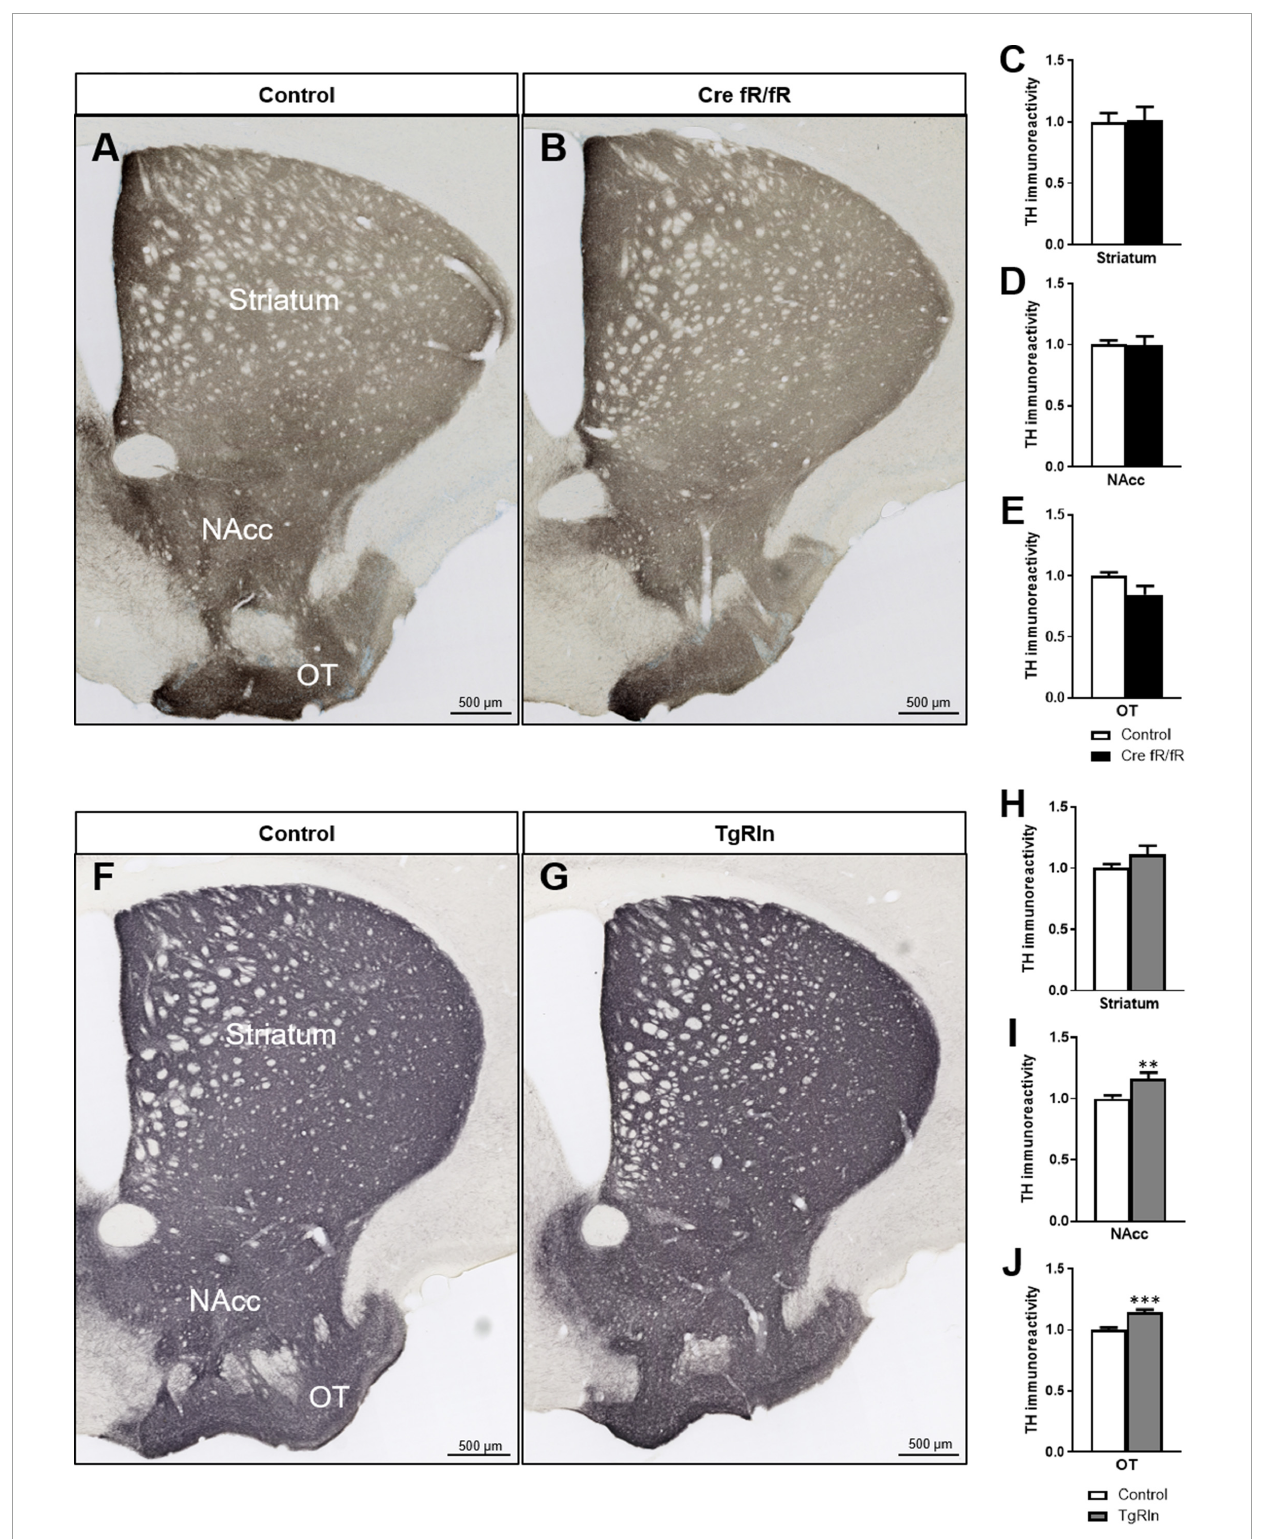
FIGURE5 Increased levels of Reelin elevates dopaminergic projections in the ventral striatum. (A,B) Immunohistochemistry for TH to stain dopaminergic projections in coronal sections of the DS, NAcc, and OT of control and Cre fR/fR mice. TH intensity remains constant in the striatum (C) , NAcc (D) , and OT (E) of Cre fR/fR mice compared to controls ( n = 4). (F,G) Immunohistochemistry for TH in control and TgRln mice. After quantification, increased TH immunoreactivity was detected in the NAcc (I) and OT (J) , but not in the DS (H) of TgRln mice compared to controls ( n = 8–14). Scale bar: (A,B,F,G) , 500 µ m. NAcc, nucleus accumbens; OT, olfactory tubercle. Statistical analyses were performed using Student’s t -test; ** p < 0.01; *** p < 0.001. Results represent the means ±